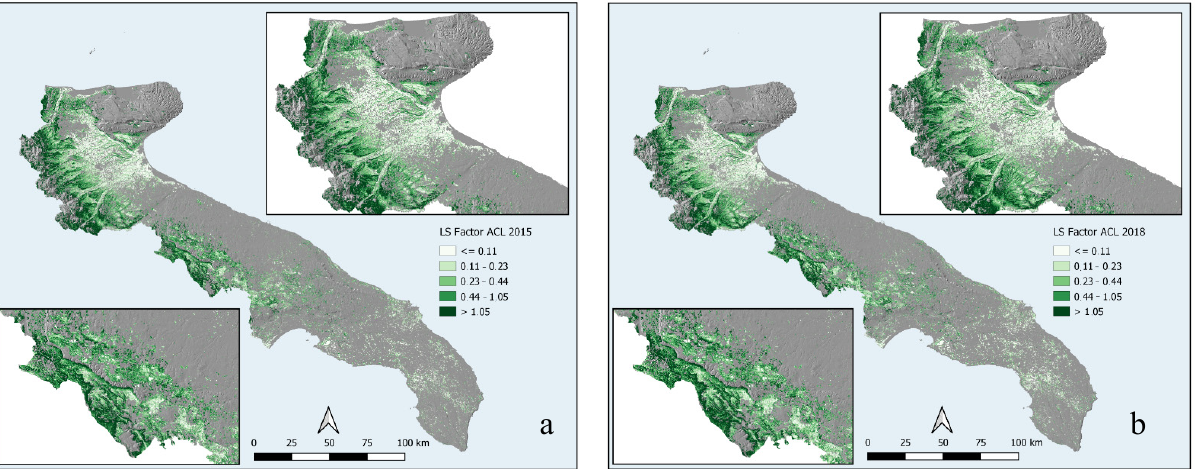
Figure 7. Support practice factor ( P ) maps of the Apulia region for annual cropland in ( a ) 2015 and ( b ) 2018.